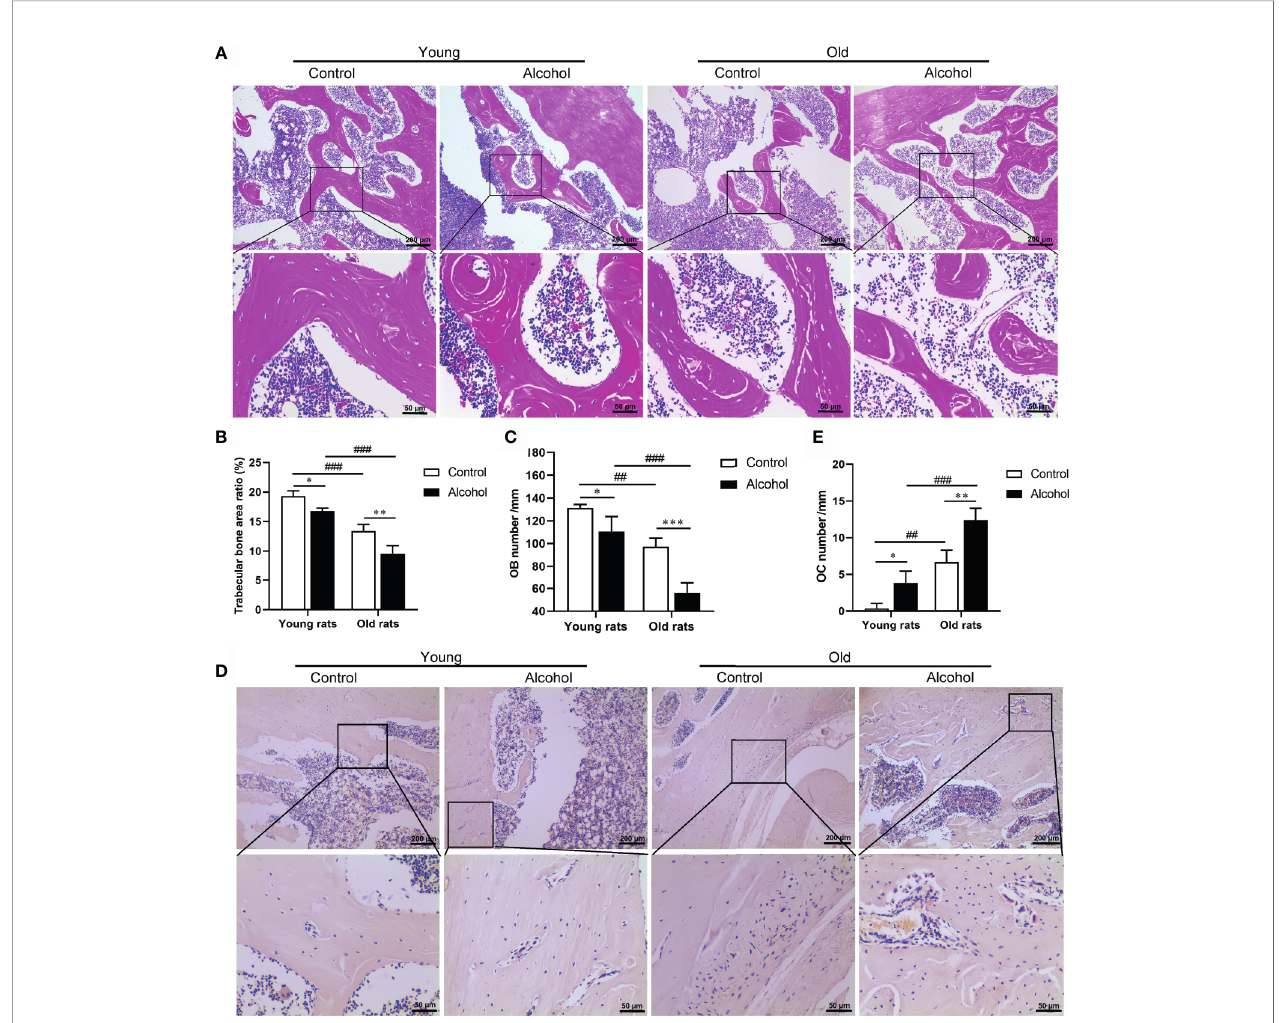
FIGURE 1 | Effects of alcohol on bone morphology in young and old rats. (A) Bone tissue was observed by HE staining, Magni fi cation, x100 and x400; (B) Trabecular bone area ratio; (C) Osteoblasts numbers; (D) Osteoclasts was observed by TRAP staining, Magni fi cation, x100 and x400; (E) Osteoclasts numbers. Data were shown as mean ± SD. n = 6, * P < 0.05, ** P < 0.01, *** P < 0.001, compared with control of the same age, # P < 0.05, ## P < 0.01, ### P < 0.001, the same group compared with young